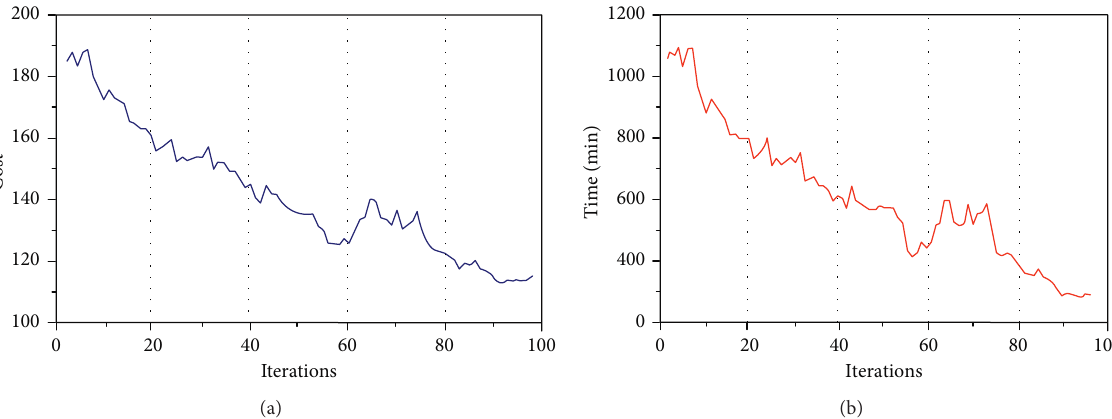
Figure 7: Test and analysis of convergence rate. (a) Change chart of dispatching cost. (b) Trend chart of the total time change.